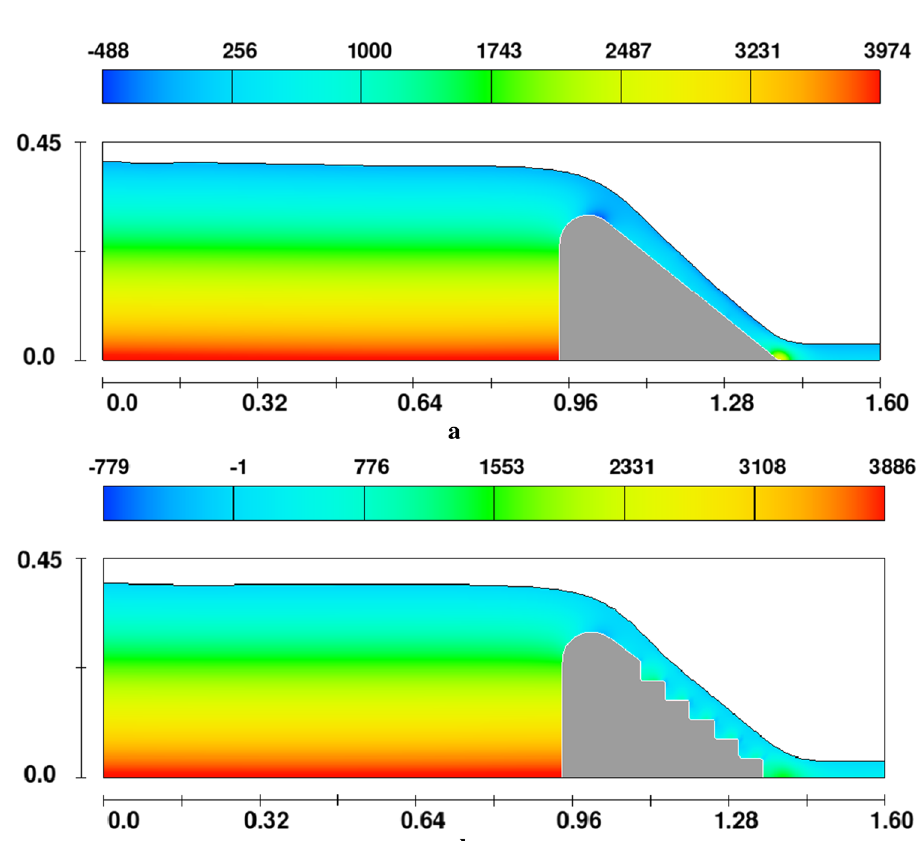
Fig. 6 The distribution of pres- sure over the smooth ( a ) and stepped chute ( b